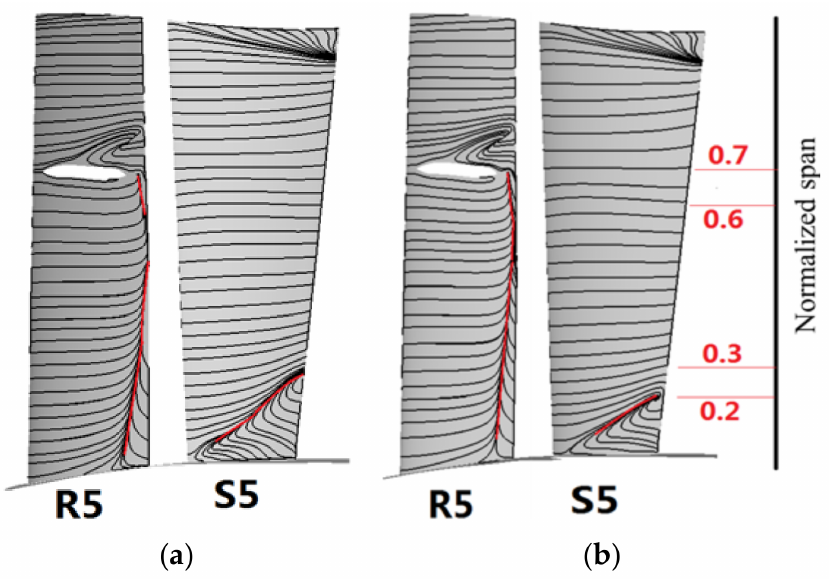
Figure 11. The limit streamline distribution of blade suction surface of the fifth stage under peak total efficiency conditions. ( a ) ABP, ( b )